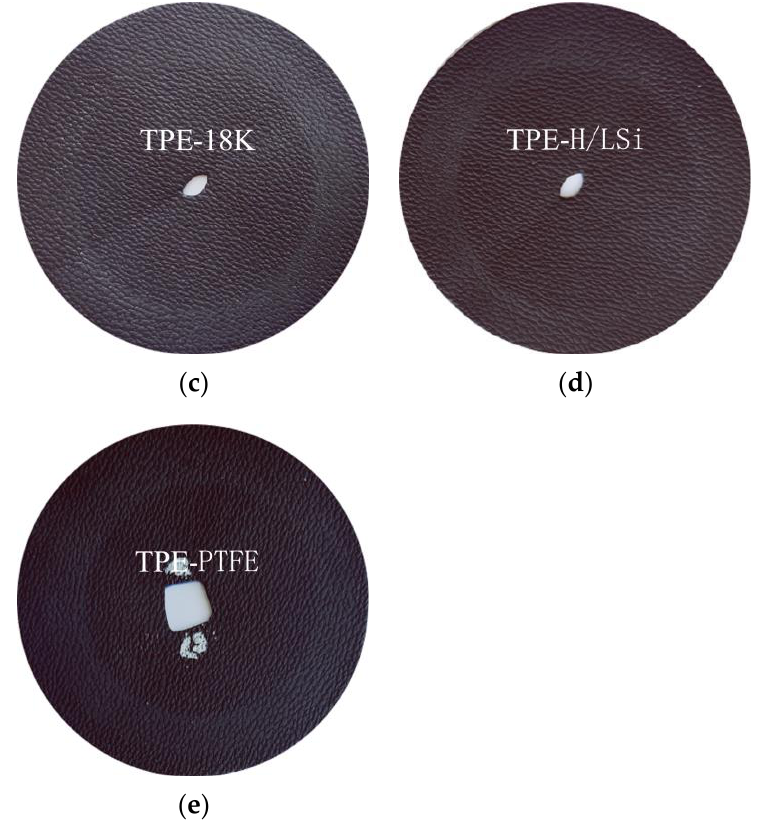
Figure 10. TPE samples prepared by various lubrication agents and masterbatches after Taber Abrasion. ( a ) TPE-HG650; ( b ) TPE-SR100B; ( c ) TPE-18K; ( d ) TPE-H/LSi; ( e ) TPE-PTFE.